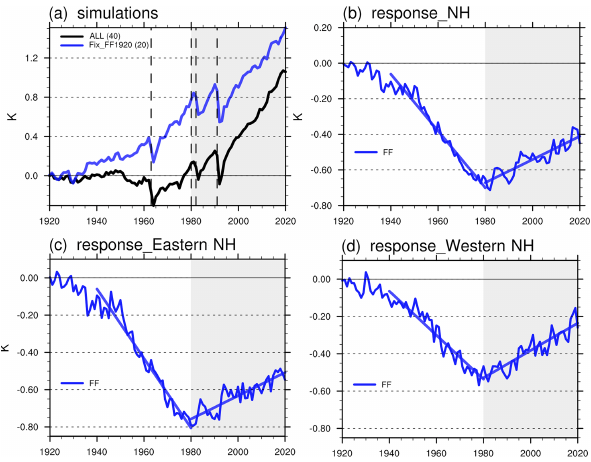
Figure 5. (a) The Northern Hemisphere (NH) surface air tempera- ture (SAT) anomalies (relative to 1920) in two sets of simulations, with ALL (all forcing – historical and RCP8.5; black line; 40 mem- ber) and Fix_FF1920 (blue line; 20 member). The four dashed lines indicate the four major volcanic eruption events (greater than cat- egory 5) during the 20th century. Shaded areas are the focused pe- riod of this study. (b) The SAT responses to FF (blue). The thicker straight lines indicate the 40-year linear fits for 1940–1980 and 1980–2020, respectively. Panels (c) and (d) are similar to panel (b) but for the EH and WH boxes (see boxes in Fig.